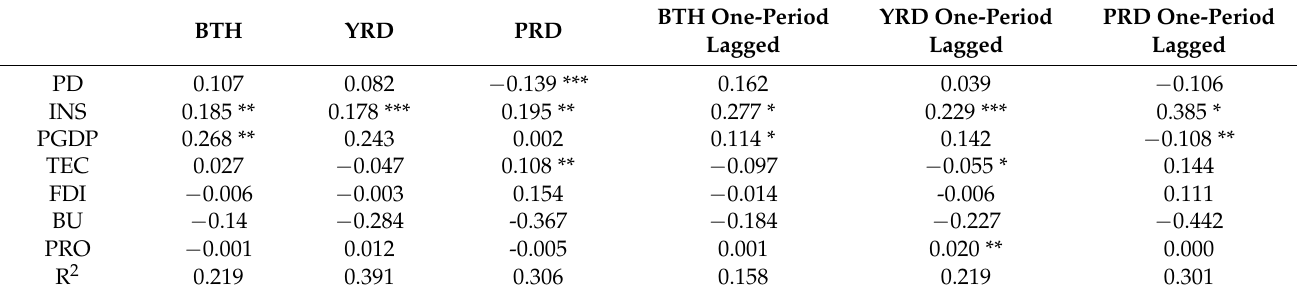
Table 5. The estimation results and robustness tests of the two-way fixed-effects model for the three major UAs in